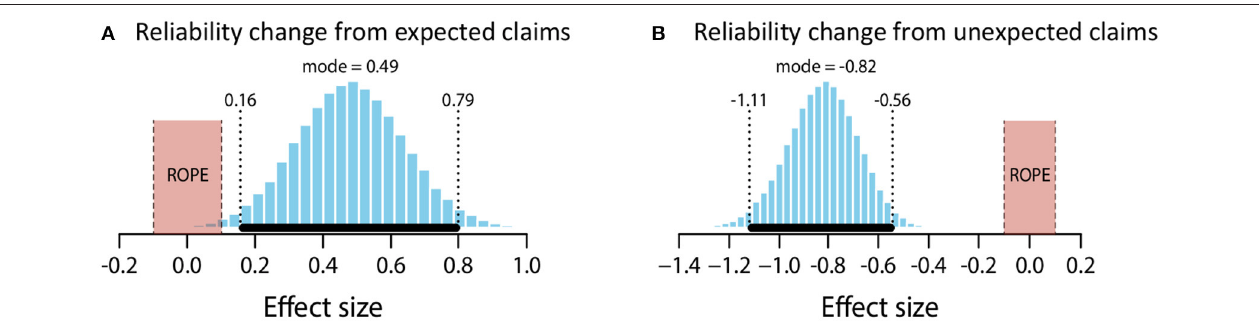
FIGURE 5 | Posterior distributions of effect size for change in perceived reliability from expected claims (A) and unexpected claims (B) . ROPE from − 0.1 to 0.1. Black bar represents 95% HDI.